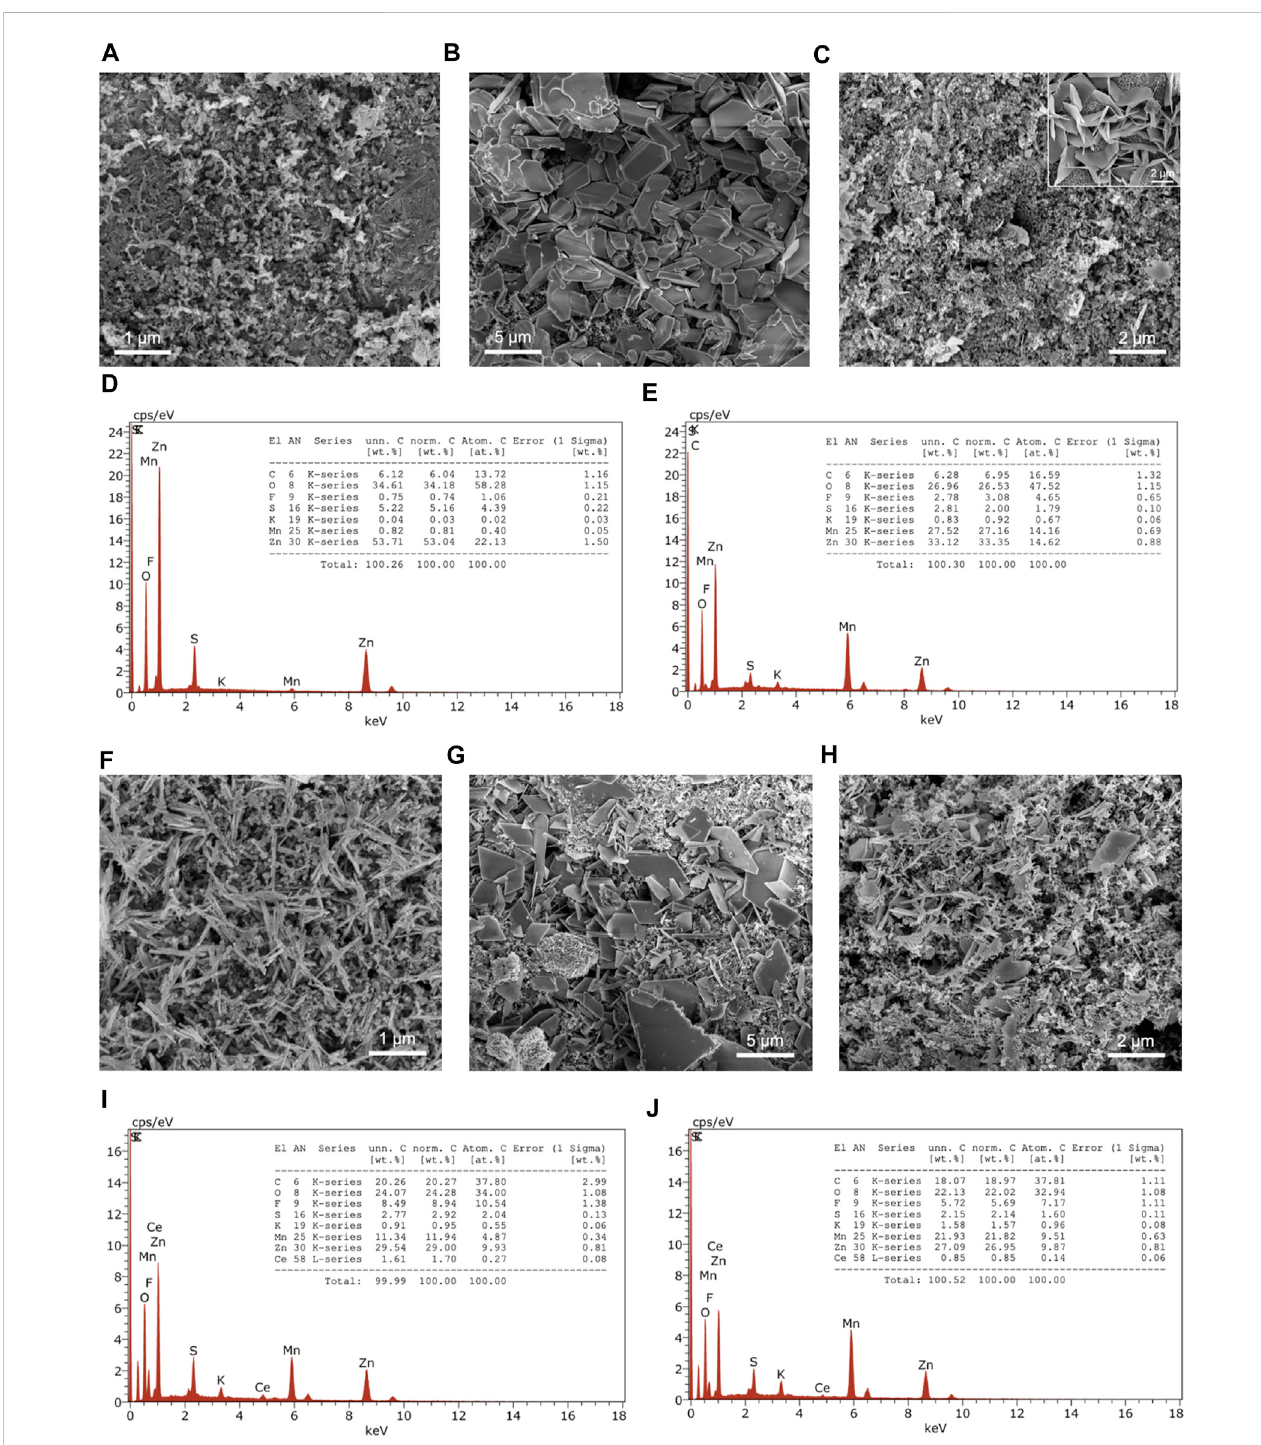
FIGURE 4 SEM images before cycling, after discharge, and after charge of (A – C) MnO 2 with EDX spectra (D) after discharge and (E) after charge, and (F – H) Ce- MnO 2 cathodes with EDX spectra (I) after discharge and (J) after charge. Inset of SEM image of